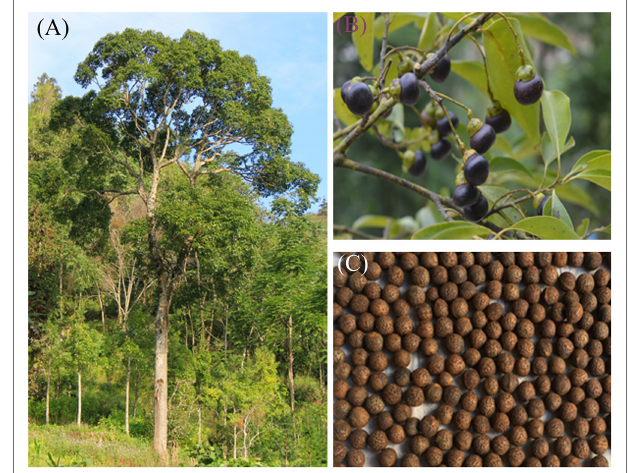
FIGURE 1 | Morphology of Cinnamomum migao mature fruits and seeds. Mature C. migao tree (A) , fruits (B) , and dried seeds encapsulated by the endocarp (C)